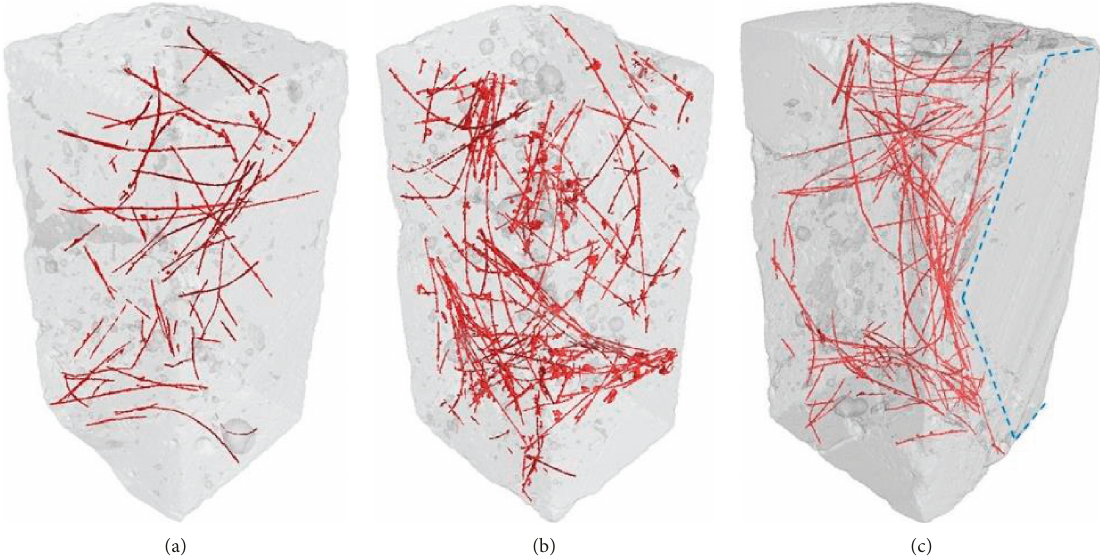
Figure 6: 3D image of distribution of fibers: (a) the sample with 0.10% volume fraction of fibers; (b) the sample with 0.20% volume fraction of fibers; (c) the sample with 0.30% volume fraction of